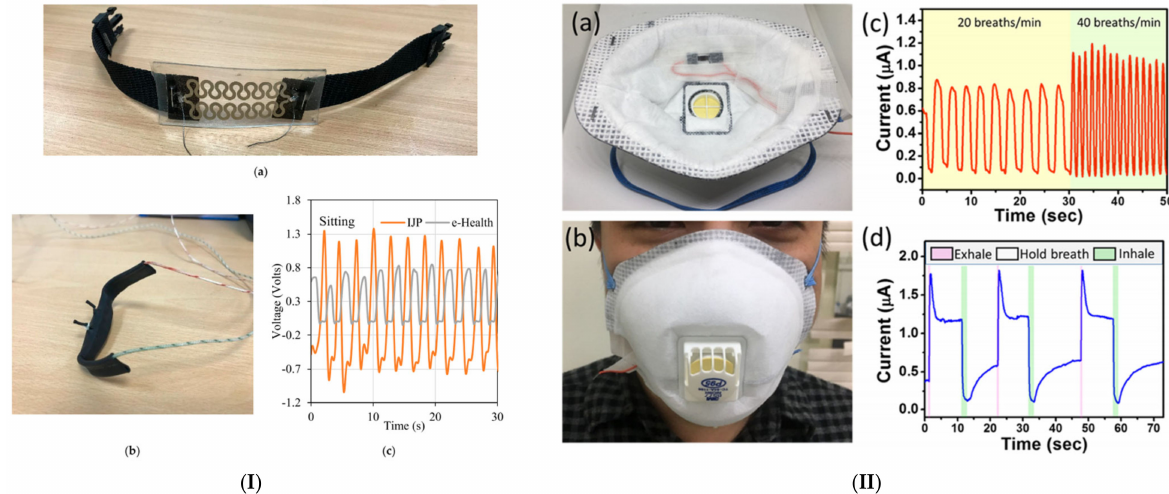
Figure 5. Selected printed respiratory rate sensors. ( I ) the inkjet-printed strain gauge sensor, along with a reference airflow sensor for results validation [184,255,256], used under the terms of Creative Common CC BY license. ( II ) Gold nanoparticles humidity sensor embedded in a facemask, reused with permission [261]. Copyright (2019) American Chemical